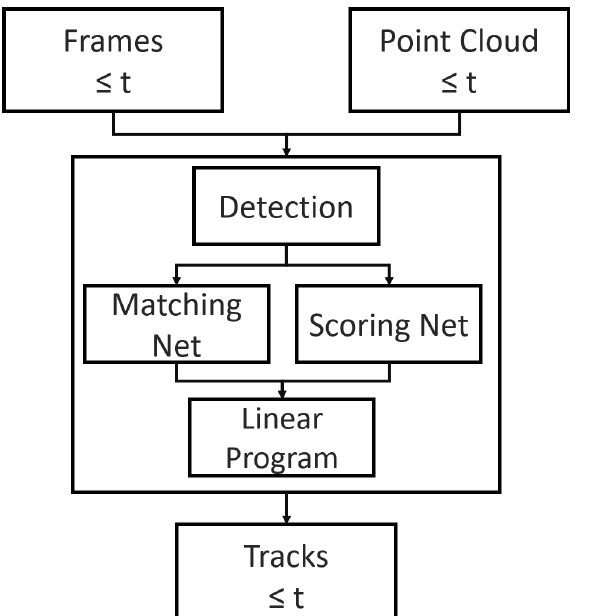
Figure 9. An end-to-end approach for 3D detection and tracking [87]. The RGB and point cloud data are passed into a detection network. Matching and scoring nets are then trained to generate trajectories across multiple